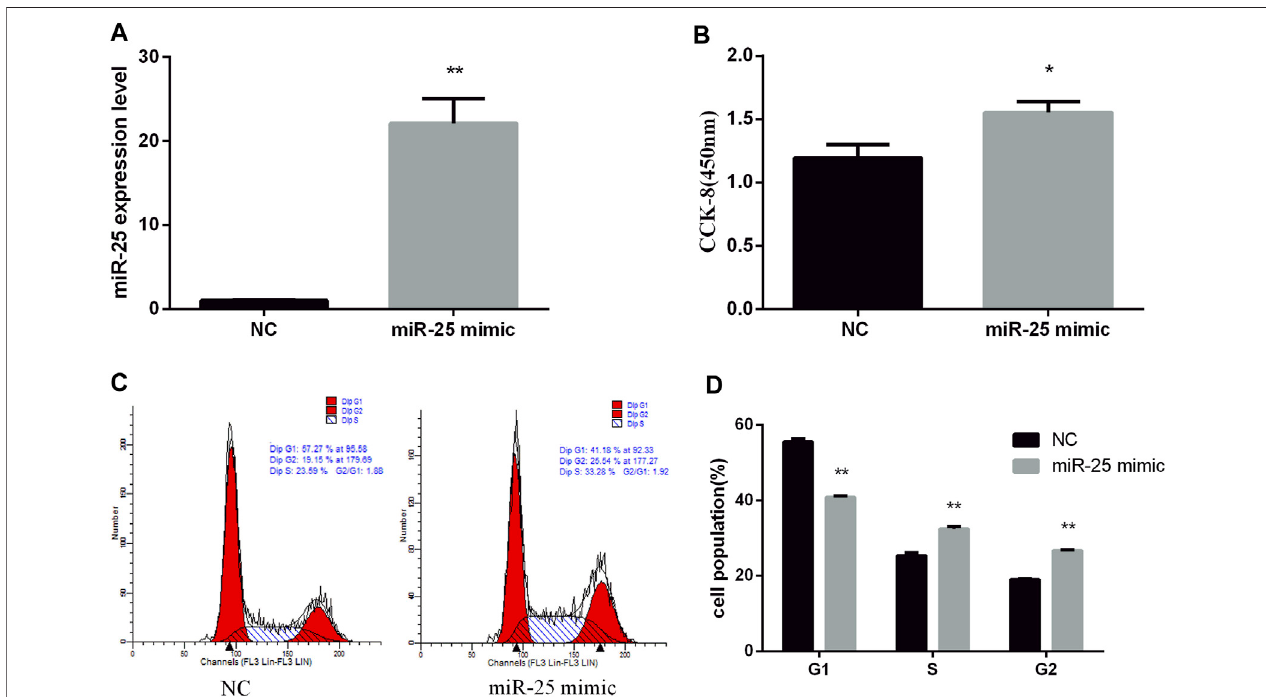
FIGURE3| OverexpressionofmiR-25promotesBGC823cellgrowth. (A) AftertransfectionofmiR-25mimicintoBGC823cell,theexpressionlevelofmiR-25wasdetectedby RT-qPCR. (B) AftergainofmiR-25,CCK-8reagentwasusedtodetectcellproliferationactivity. (C) Cellcyclewereanalyzedby fl owcytometryafterbeingtransfectedwithmiR-25mimic. (D) Cell number statistics at each stage of cell cycle. Value in graphs represents means ± SD. At least three independent experiments were carried out. ** p < 0.01; * p <